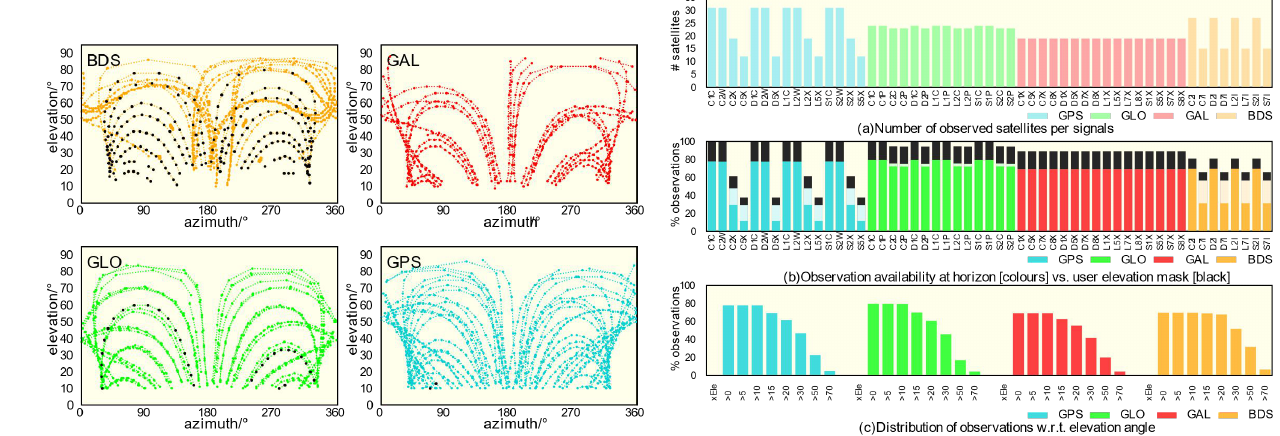
Figure 2. Satellite sky tracks